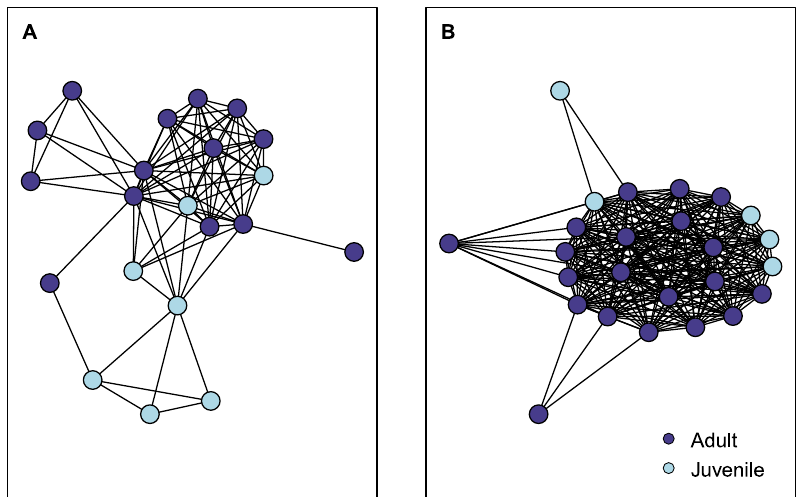
Figure 4. Indiana bat ( Myotissodalis ) social network maps. Single-mode social network map of an Indiana bat maternity colony in Pickaway County, Ohio, USA, 2009 (A) and 2010 (B). Map projected from the two-mode network of bats and roosts. Nodes are colored by age